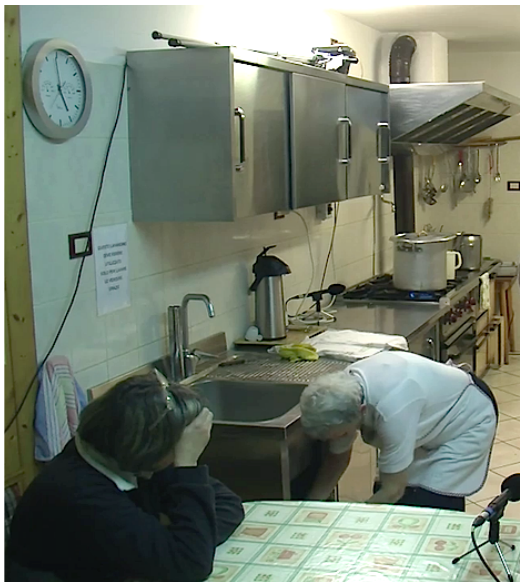
Figure 2: Extract (3) line 4. Piera leans up and initiates repair (‘huh?’).